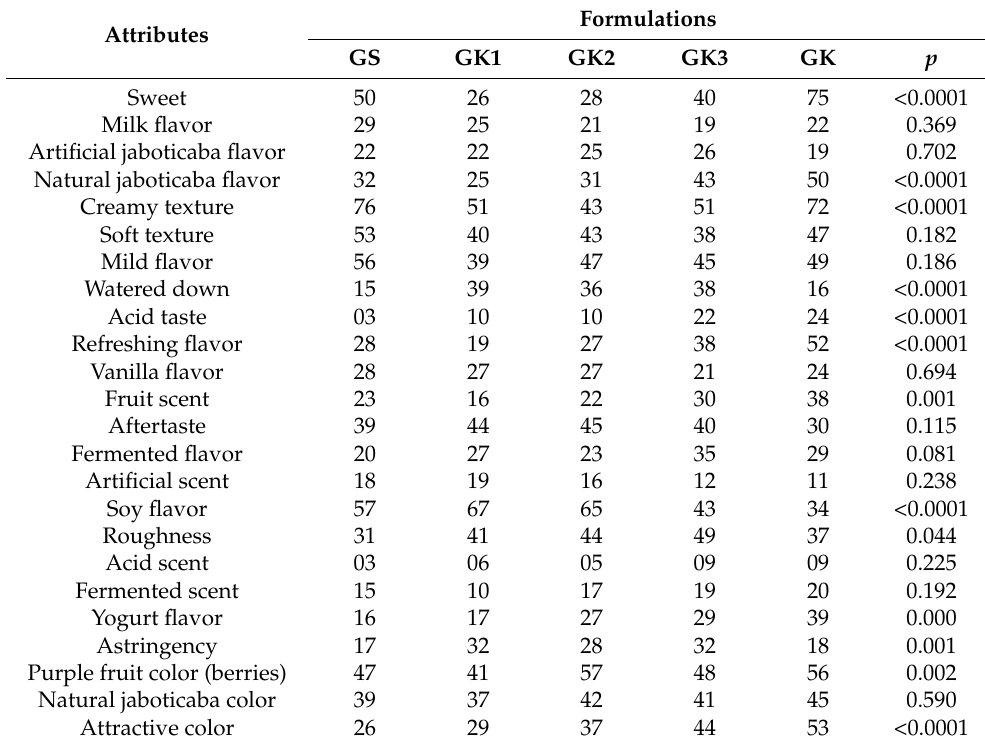
Table 9. Frequency of sensory attributes and Cochran’s Q test associated with each ice cream at the end of the storage period